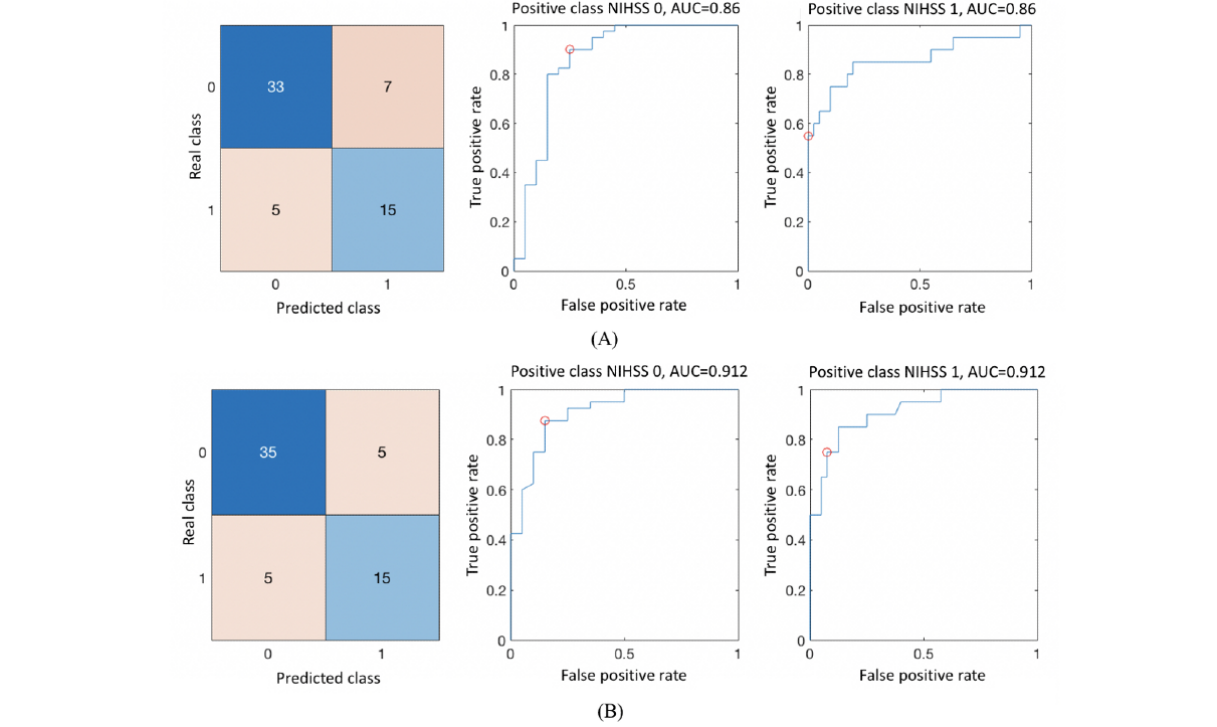
Figure 6. Confusion matrix and receiver operating characteristic of auto-NIHSS grading using (A) support vector machine and (B) ensemble learning. AUC: area under the receiver operating characteristics curve; NIHSS: National Institutes of Health Stroke Scale.